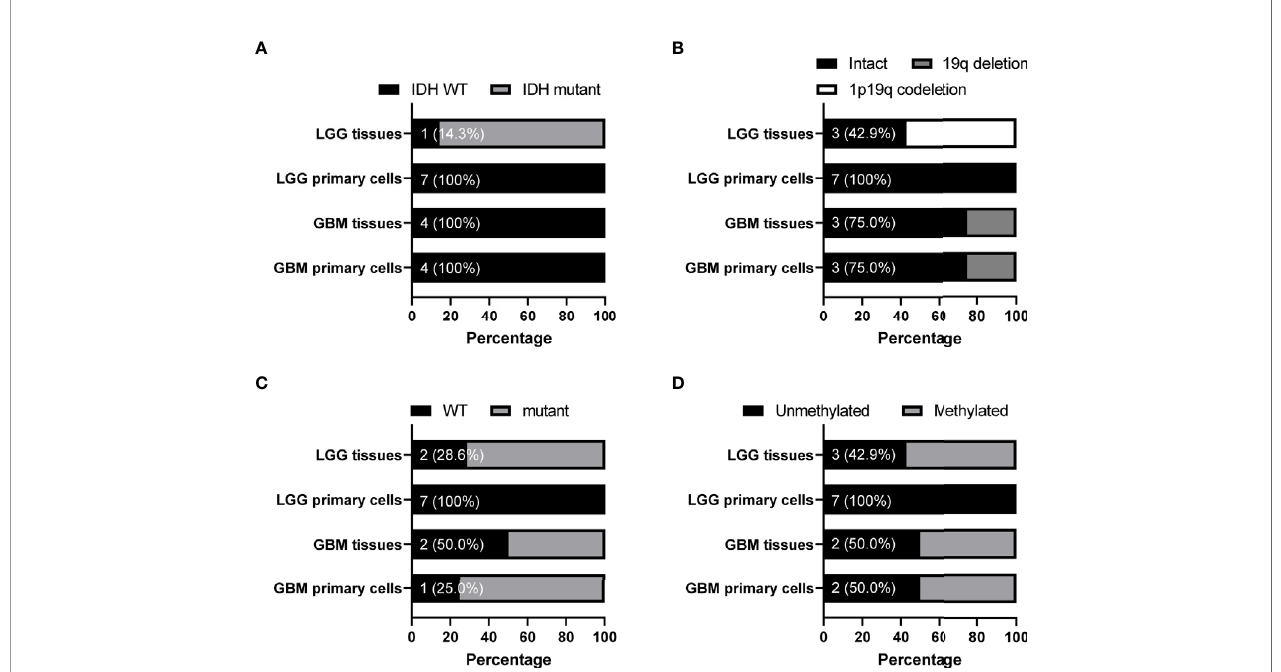
FIGURE 6 | Preservation status of glioma molecular markers in patient-derived primary cells compared to their original specimens in the grade II/III and GBM groups. The status of IDH mutation (A) , chromosome 1 p arm and chromosome 19 q arm deletion (B) , TERT promoter mutation (C) , and MGMT promoter methylation (D) in 7 grade II/III and 4 GBM paired tumors and primary cells were determined. The numbers indicated the number of tissue or cell with wild type IDH or TERT promoter, intact 1p/19q, or unmethylated MGMT promoter. WT, wild